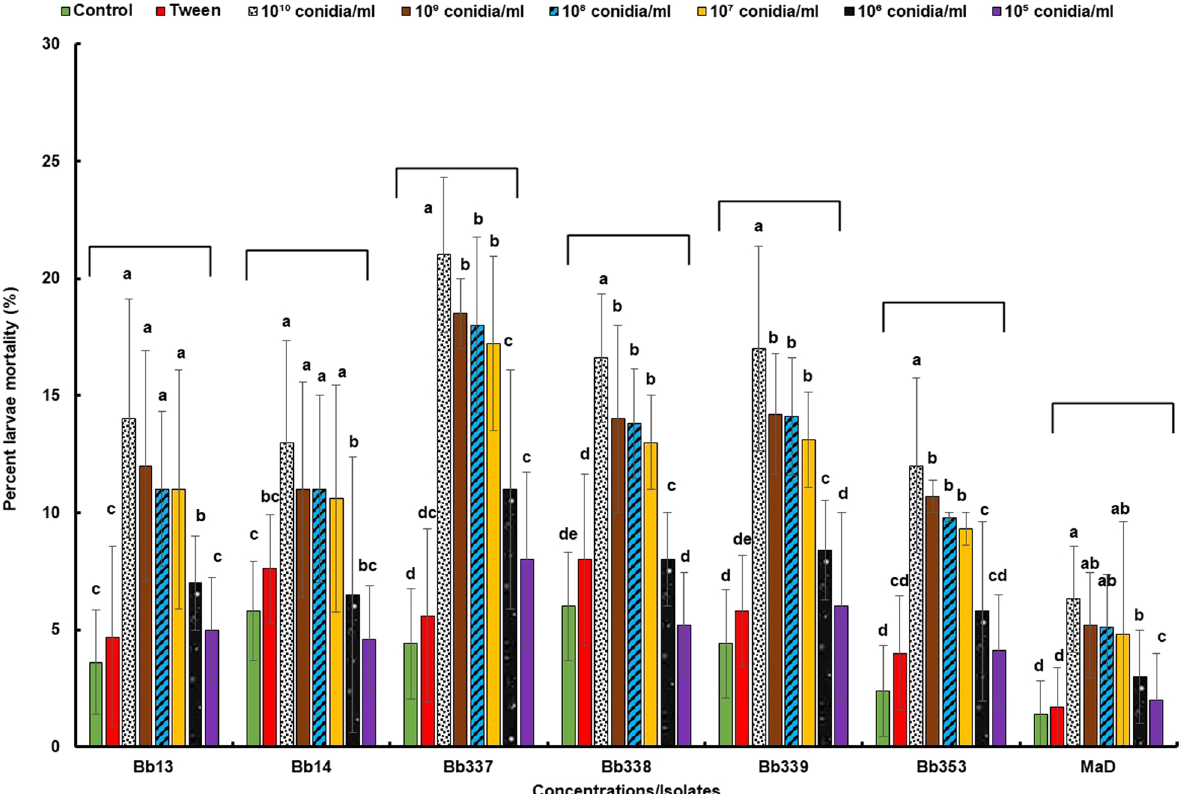
Fig. 1 Mortality of larvae of Zeugodacus cucurbitae treated with different concentrations of isolates of Beauveria bassiana and Metarhizium anisopliae in larval inoculation